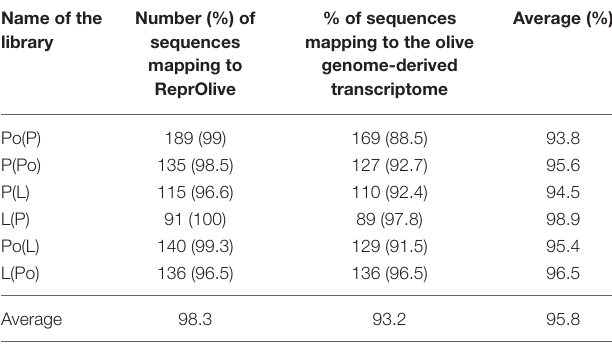
TABLE 5 | Percentages of “pre-cleaned” SSH transcripts mapping to the two recently developed olive transcriptome databases (ReprOlive: Carmona et al., 2015; Cruz et al.,